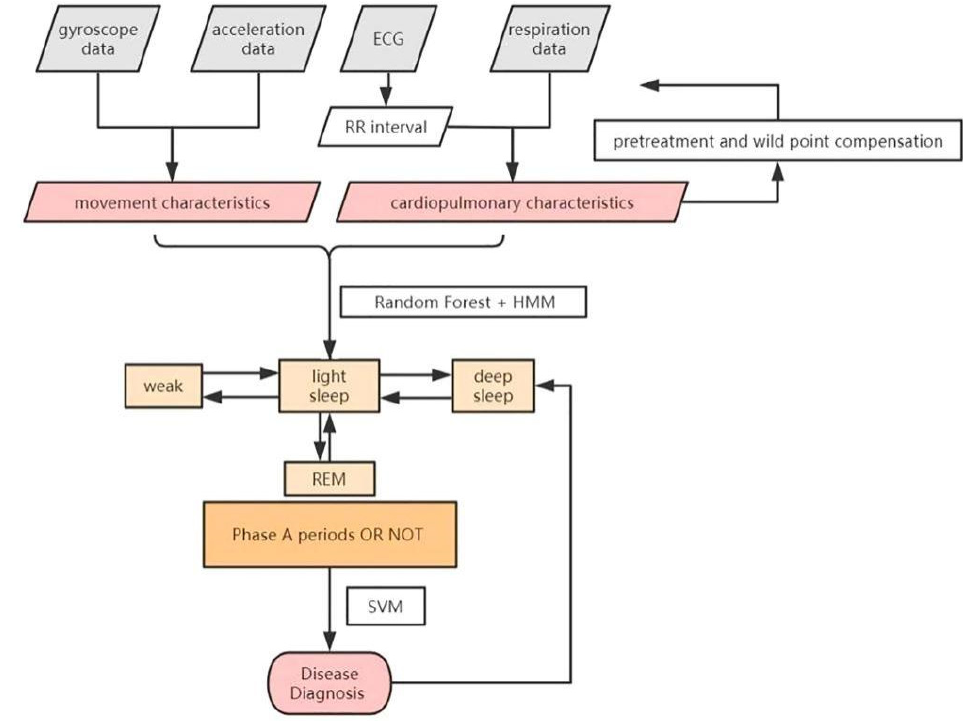
Figure 4. The classification and diagnosis scheme.